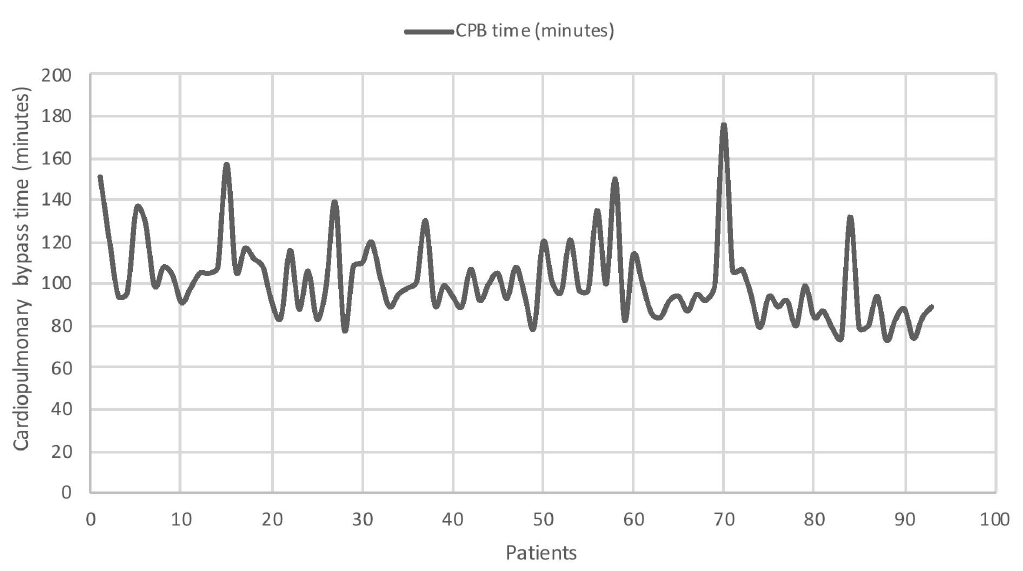
Fig. 1 - Trend of cardiopulmonary bypass times over